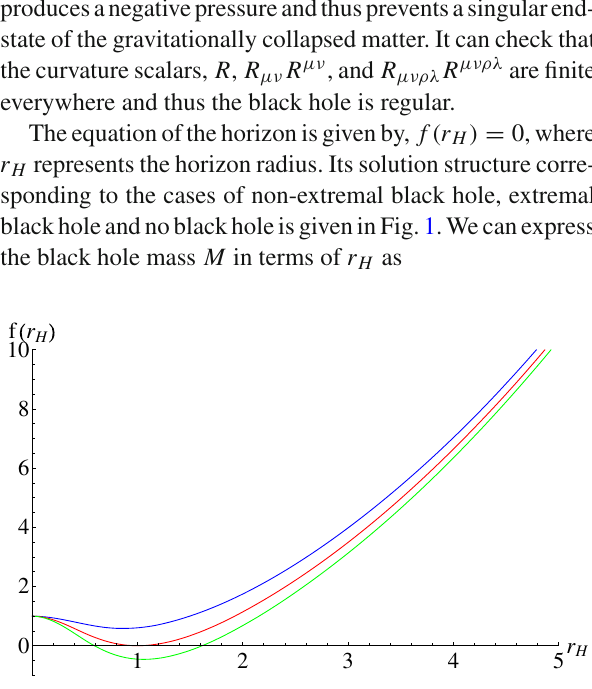
Fig. 1 The function f ( r H ) is plotted in terms of the horizon radius r H , at Q = 1 and l 2 = 12 / 5, for the different values of the mass M . The green, red and blue curves correspond to M = 3 (non-extremal black √ hole), M = 5 2 / 3 (extremal black hole), and M = 2 (no black